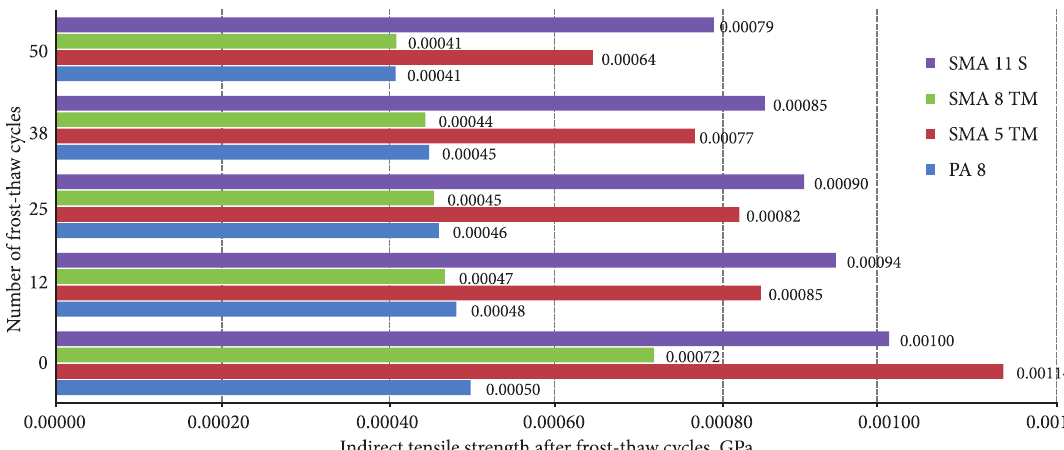
Fig. 8. Testing results of indirect tensile strength after frost-thaw